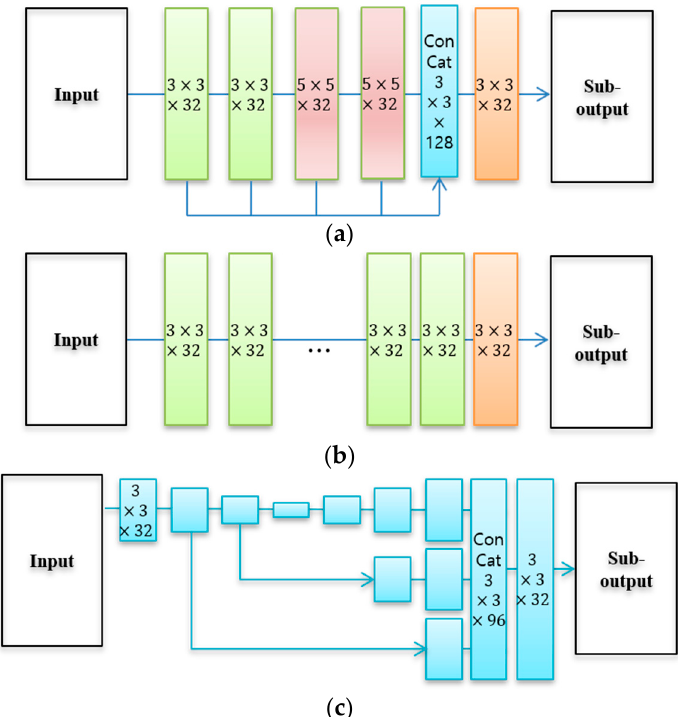
Figure 3. Architectures of sub-network: ( a ) multi-scale CNN (sub-net 1), ( b ) forward CNN (sub-net 2), ( c ) auto-encoder (sub-net 3).